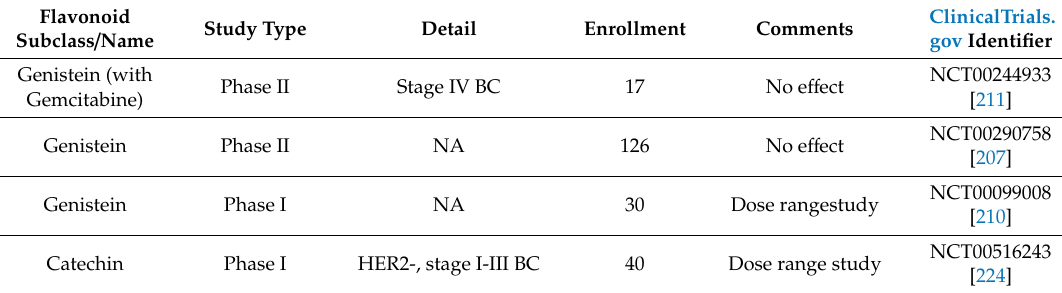
Table 4. Clinical trials on dietary intake of flavonoids and breast cancer